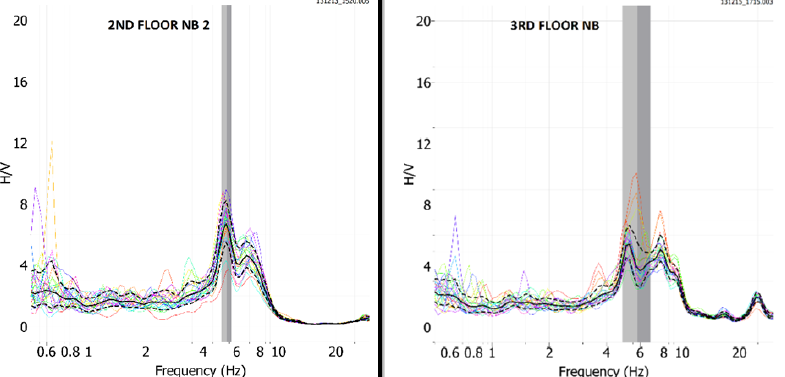
Figure 21. HVSR plots of acceleration recordings for second floor new building (left figure), and third floor new building (right figure).